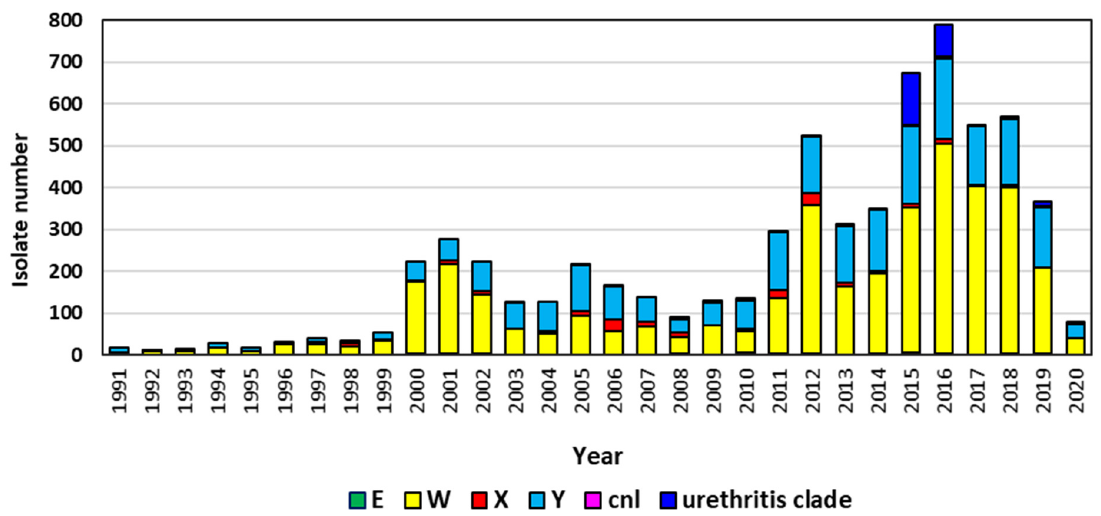
Figure 2. N. meningitidis capsular groups E, W, X, Y, and cnl from invasive meningococcal disease and urotropic